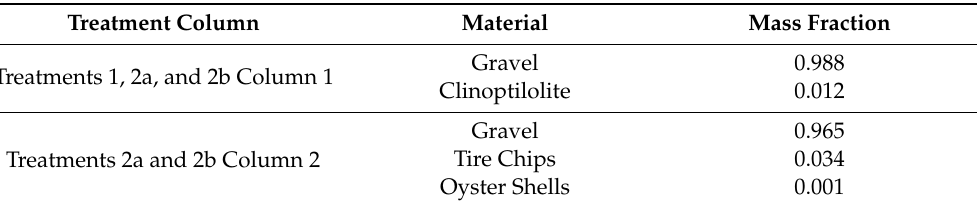
Table 4. Fraction of media added by